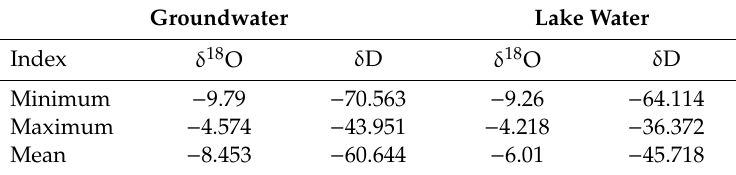
Table 4. Statistical analysis results for δ D and δ 18 O contents in lakes and